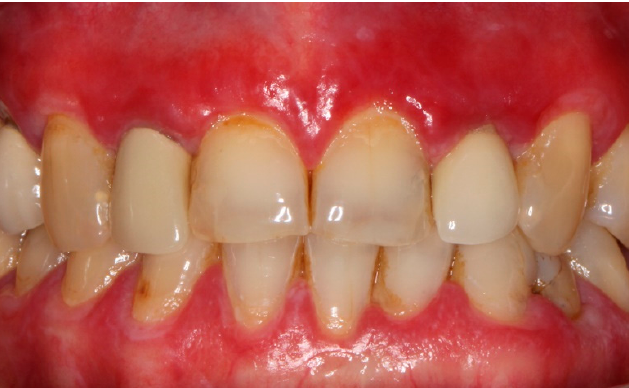
Figure 2. Desquamative gingivitis in a patient with oral lichen planus.